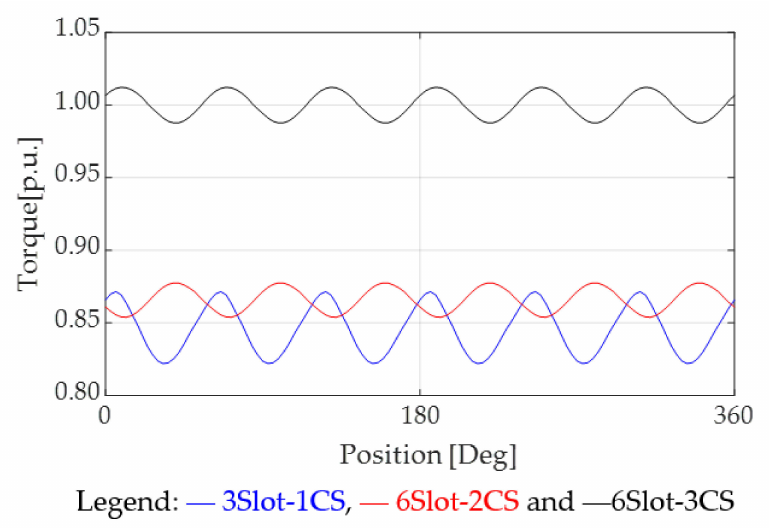
Figure 5. Torque output comparison among three analyzed slotted stators: 3Slot-1CS, 6Slot-2CS, and 6Slot-3CS (the same ampere